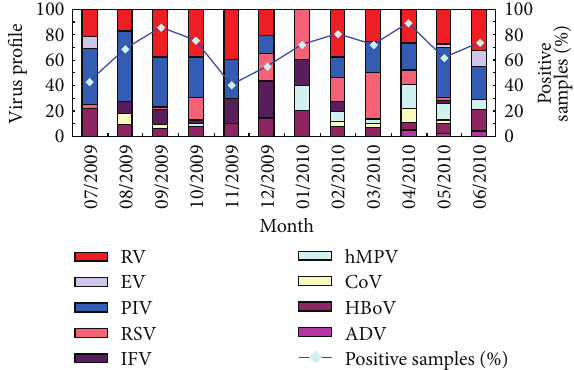
Figure 3: Number of positive results for various viruses in patients with acute lower respiratory tract